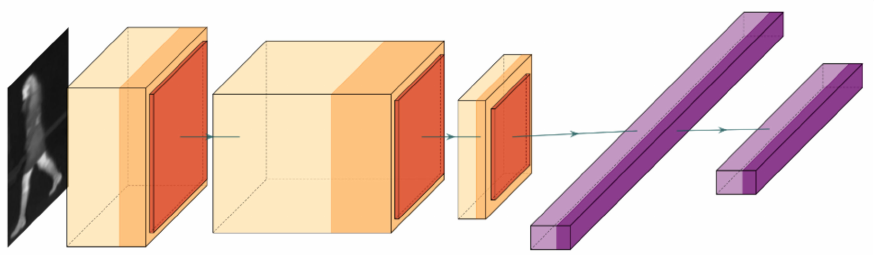
Figure 3. Graphical depiction of the embedding function ϕ used for generating the features for the input